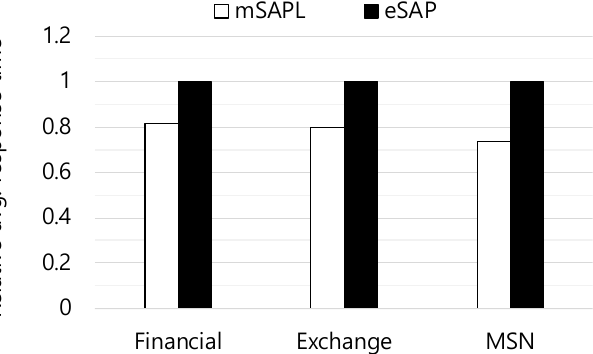
Figure 6. Comparison of average response